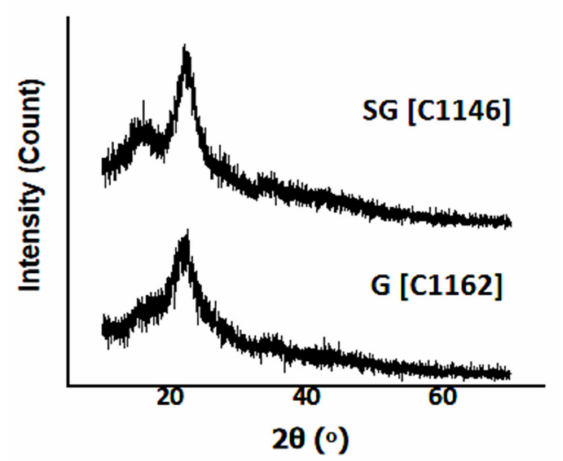
Figure 12. Diffractograms of sawdust (SG) and rice husk (G)